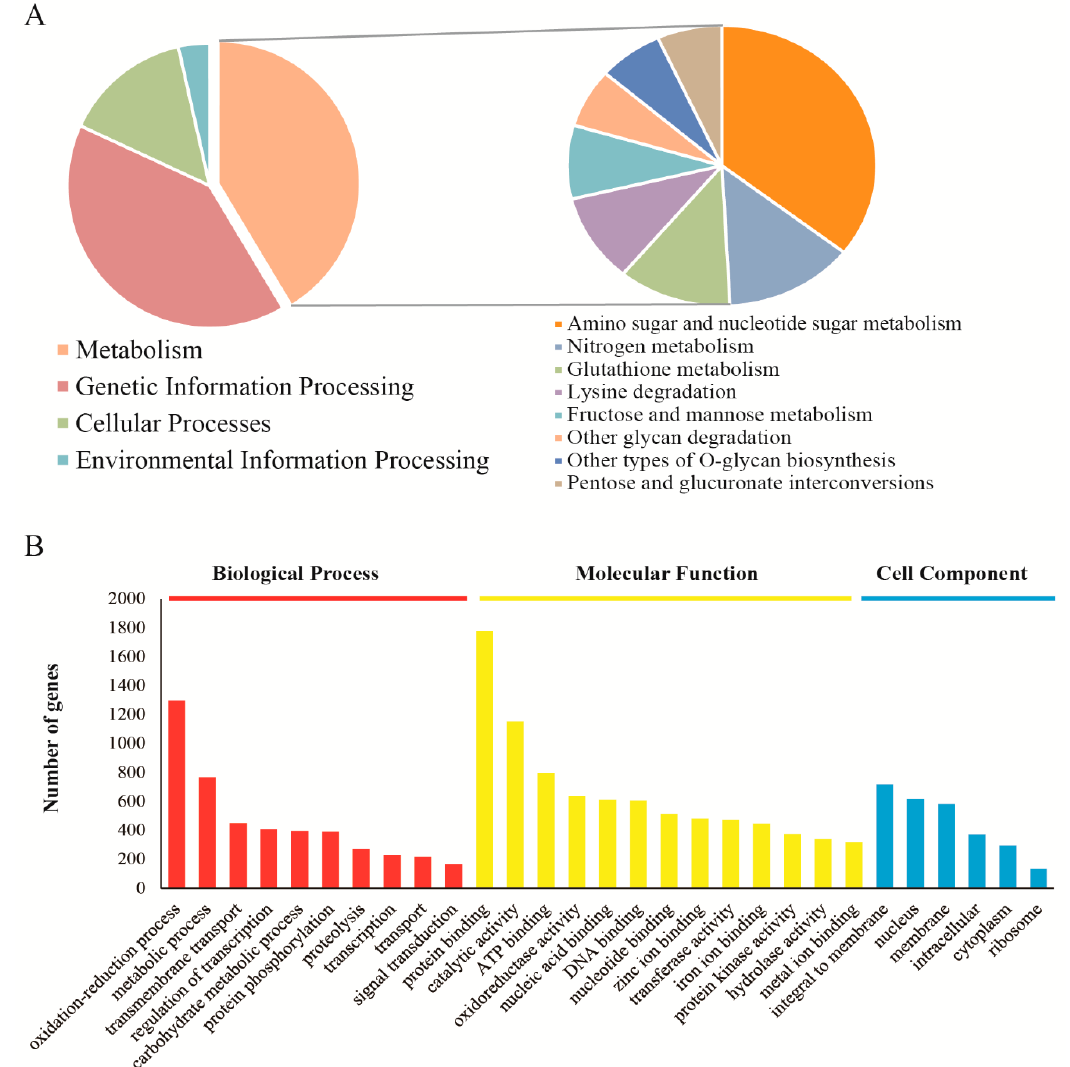
Figure 2. Functional annotation of V. volvacea . ( A ) Pie chart showing the percent of genes enriched on the KEGG pathways from transcriptome data. ( B ) GO annotation of unigenes, including the biological process, molecular function and cell component.